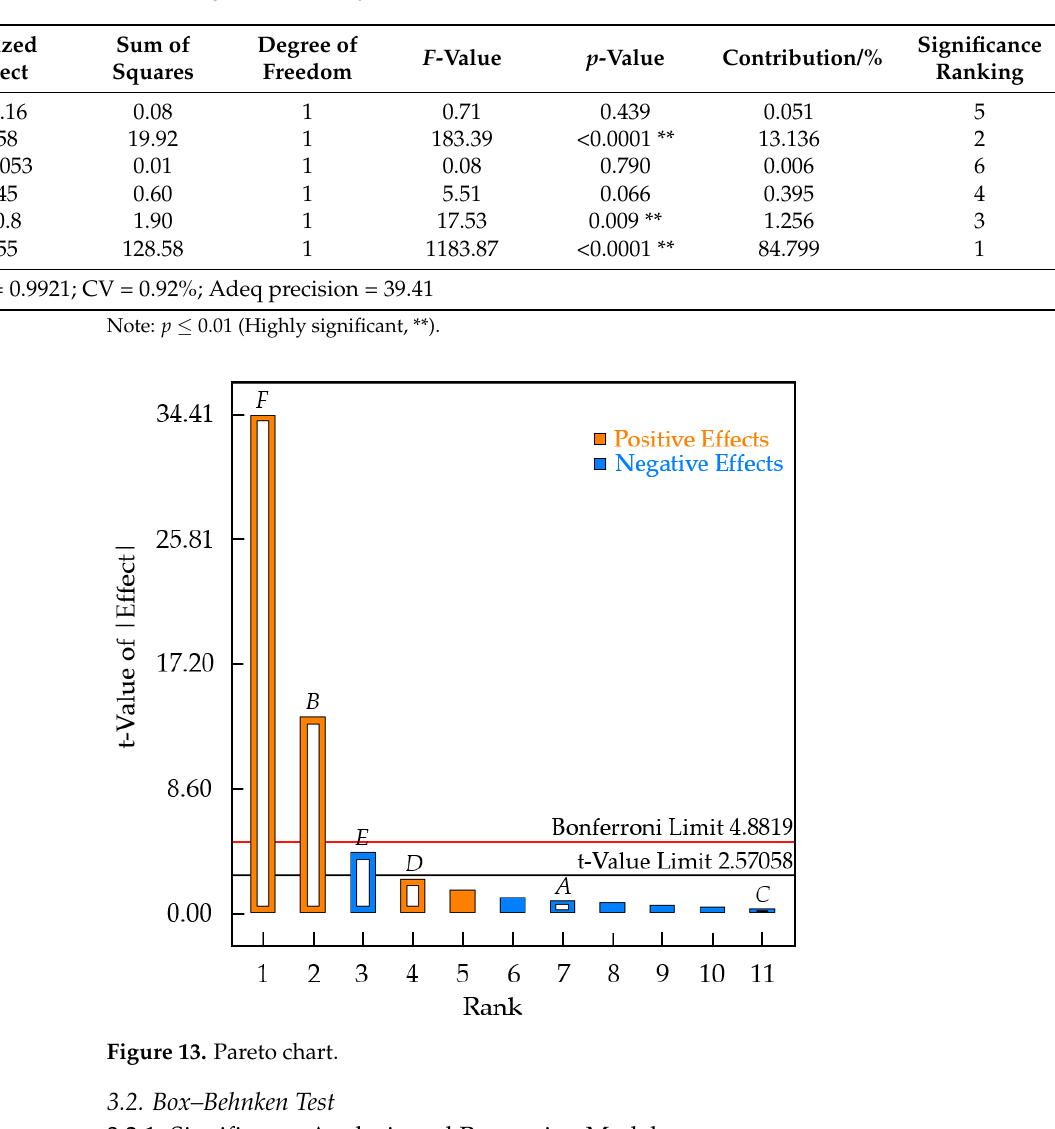
Table 4. Significance analysis of Plackett–Burman test results.